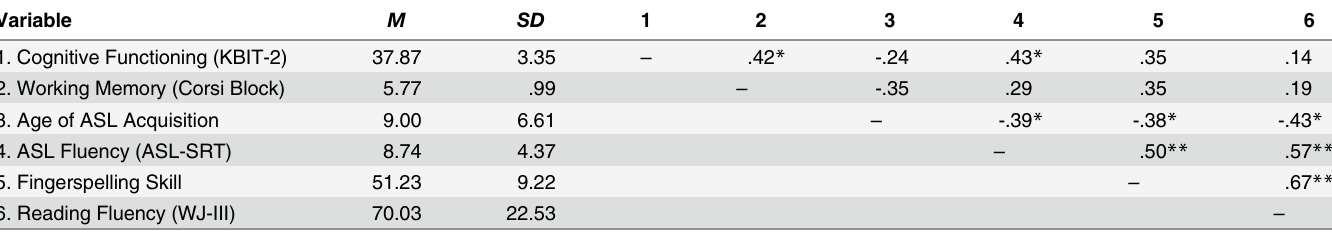
Table 1. Means, standard deviations, and inter-correlations of predictor and outcome variables. Variable